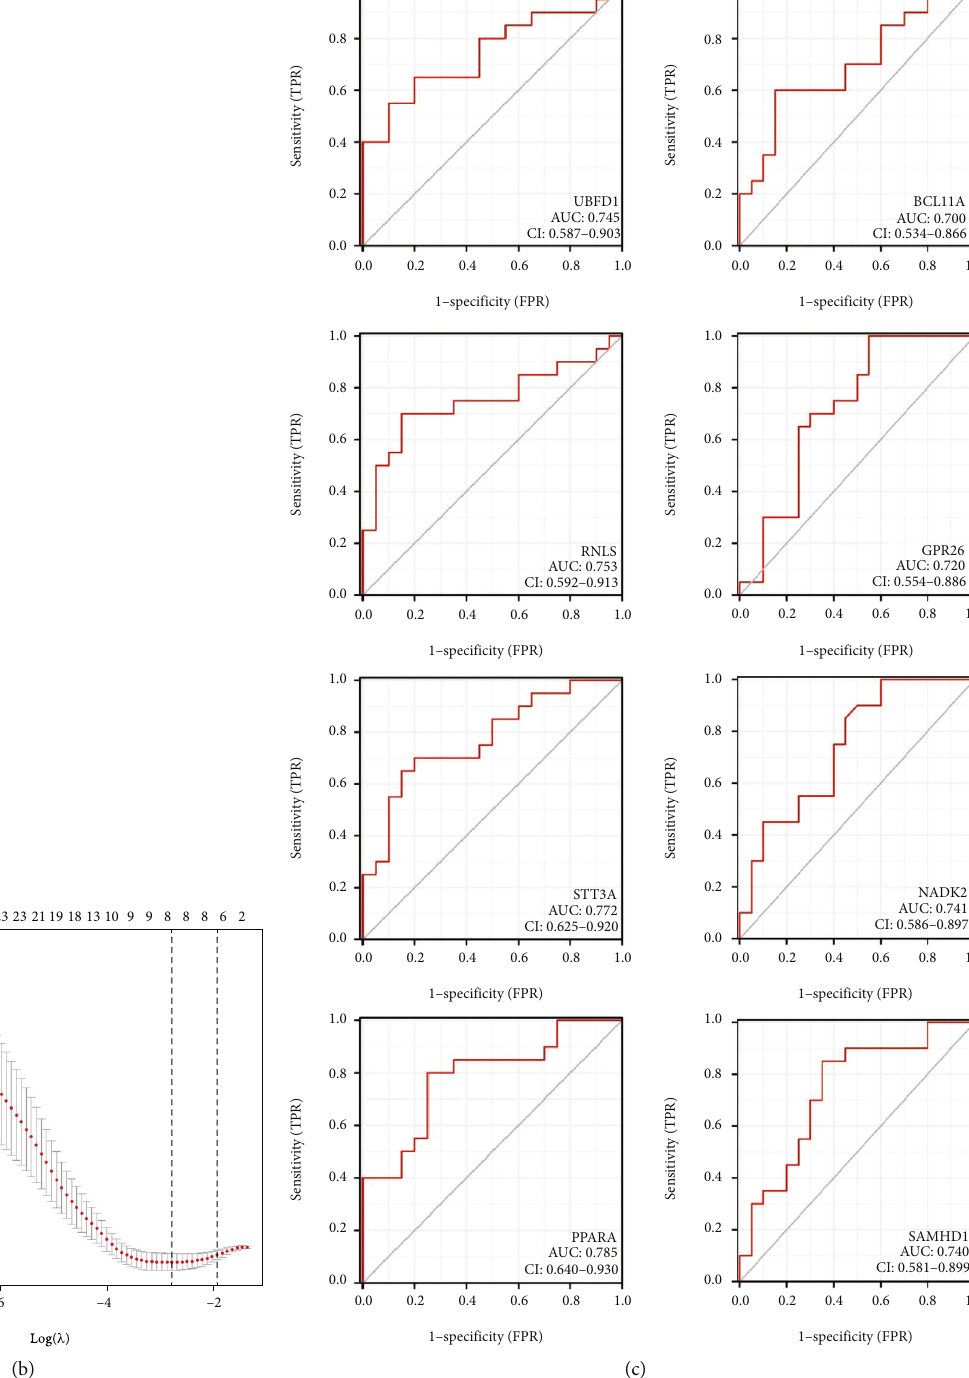
Figure 5: PPI network construction and validation of predictive feature biomarkers. (a) PPI network of the 25 intersected genes constructed by GENEMANIA. (b) A plot of biomarkers selection by LASSO regression algorithm. (c) ROC diagnostic curve for the eight genes selected by ASSO regression